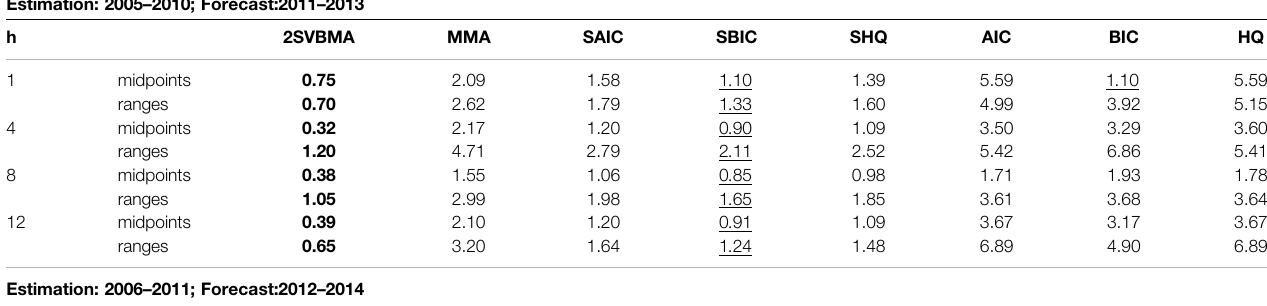
TABLE 4 | MSPE (10 − 2 ) of the recursive prediction for interval-valued crude oil prices (I). Estimation: 2005 – 2010; Forecast:2011 –